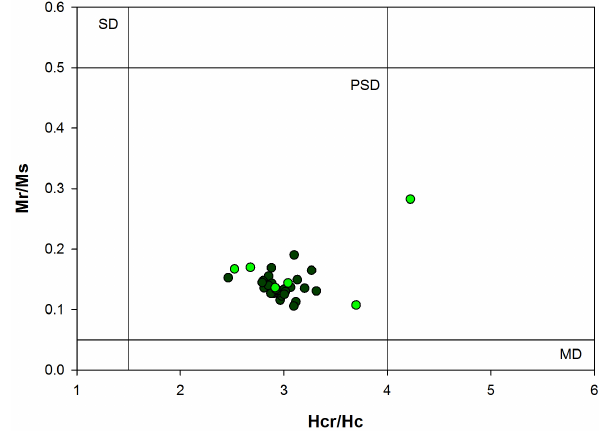
Fig. 6. Day plot of LZ1029 (dark green circles) and PG1351 (light green circles) all plotting within the PSD